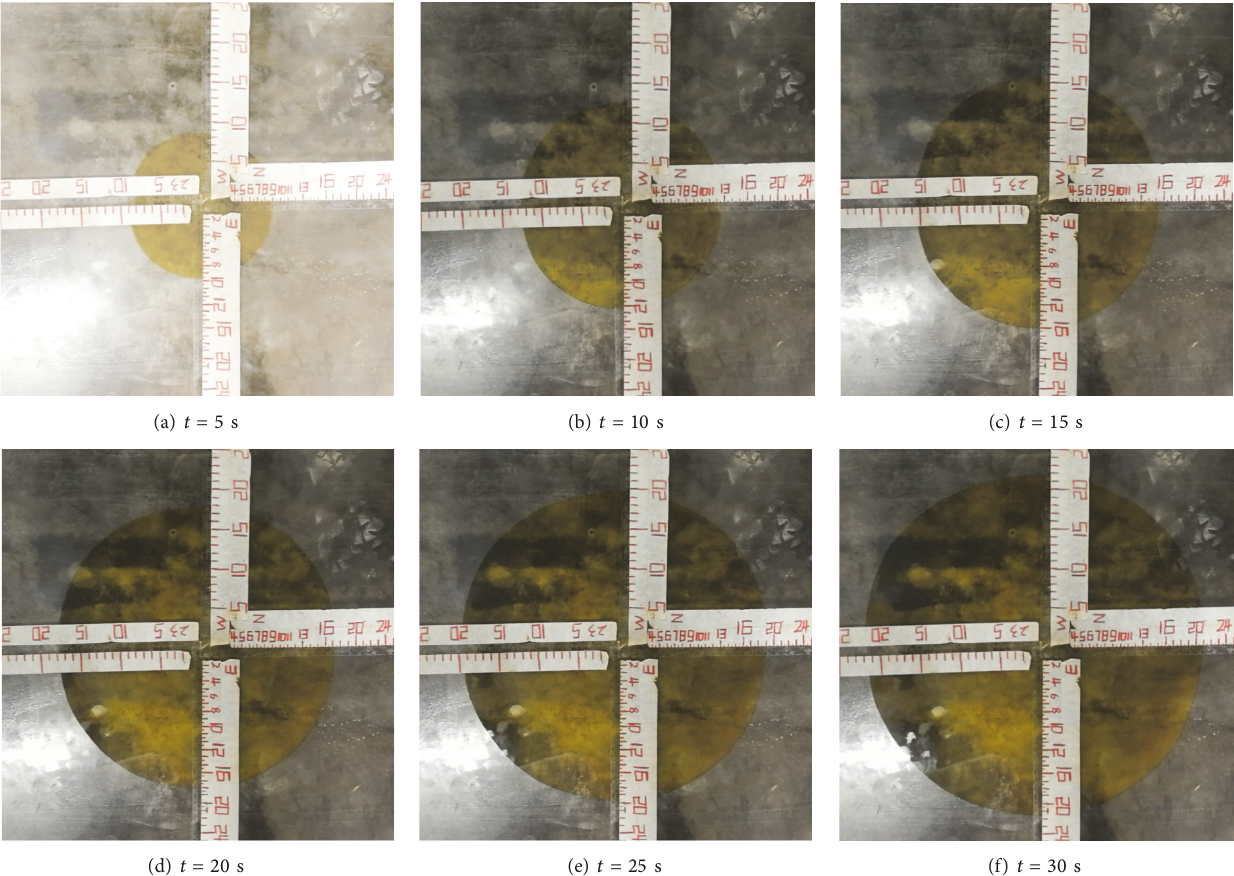
Figure 18: Variation of the grout diffusion region with time in the experiment.